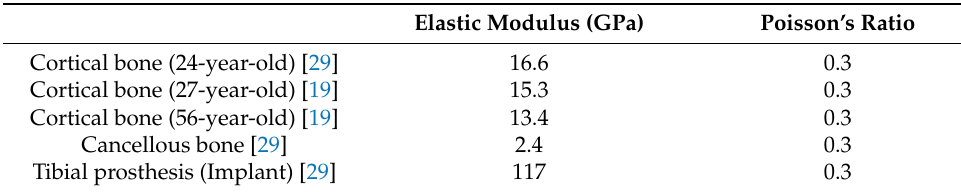
Table 1. TKR knee material